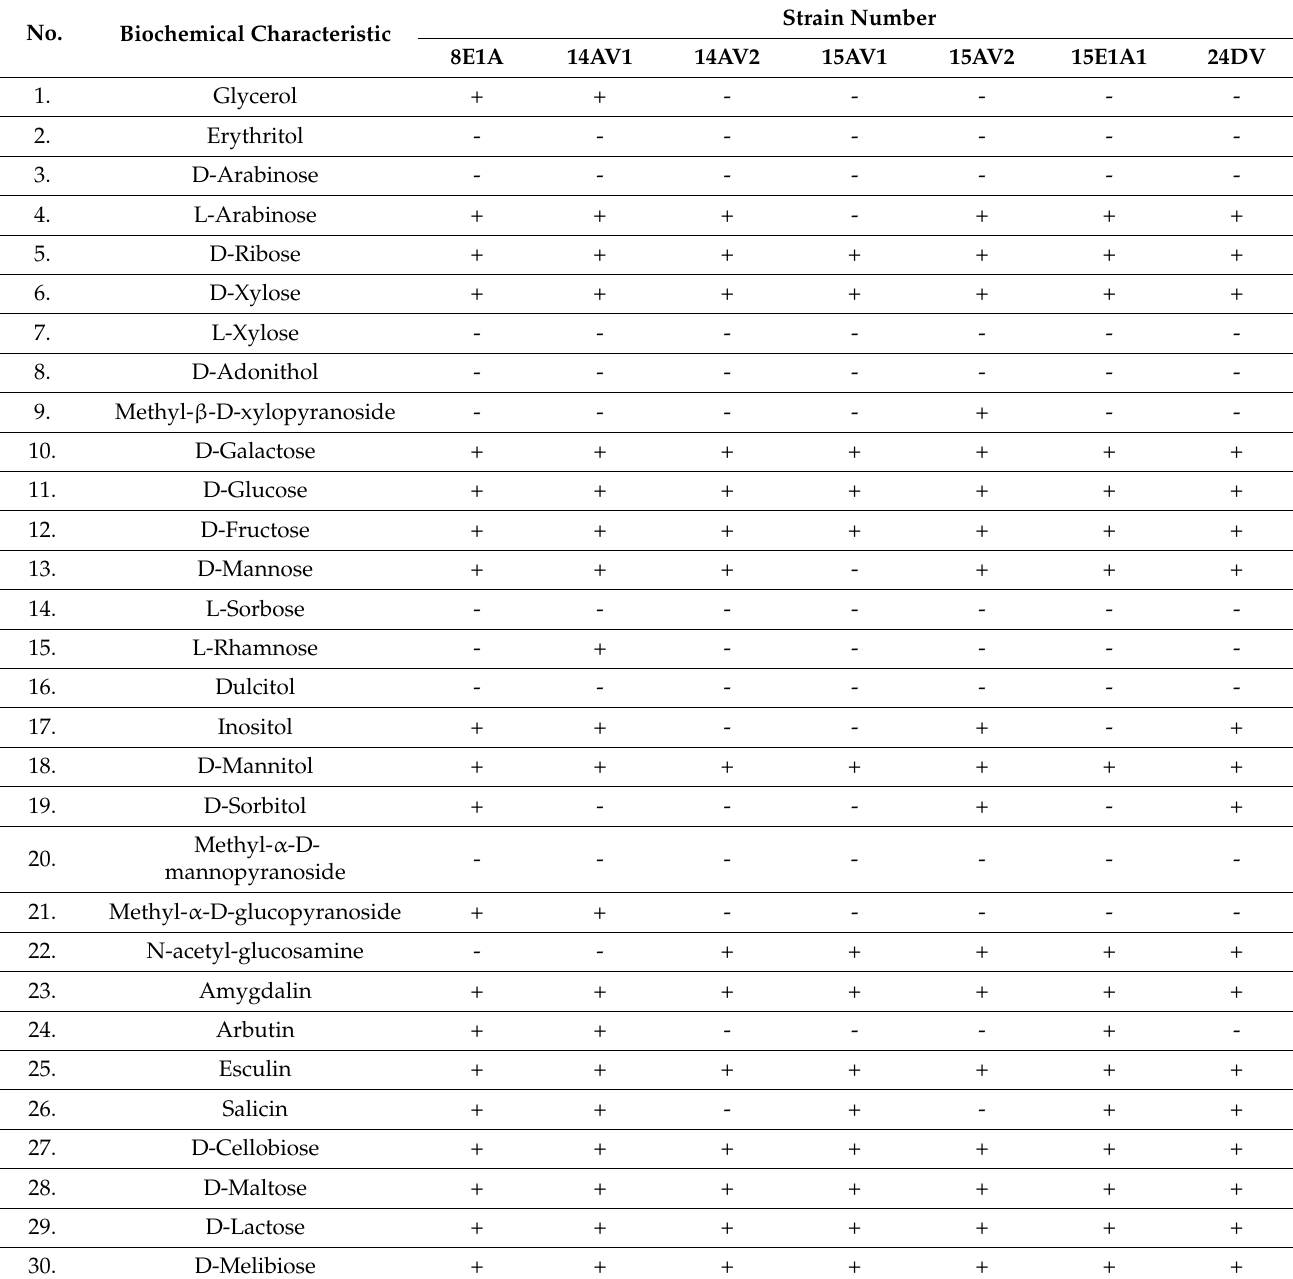
Table 1. Biochemical characteristic of